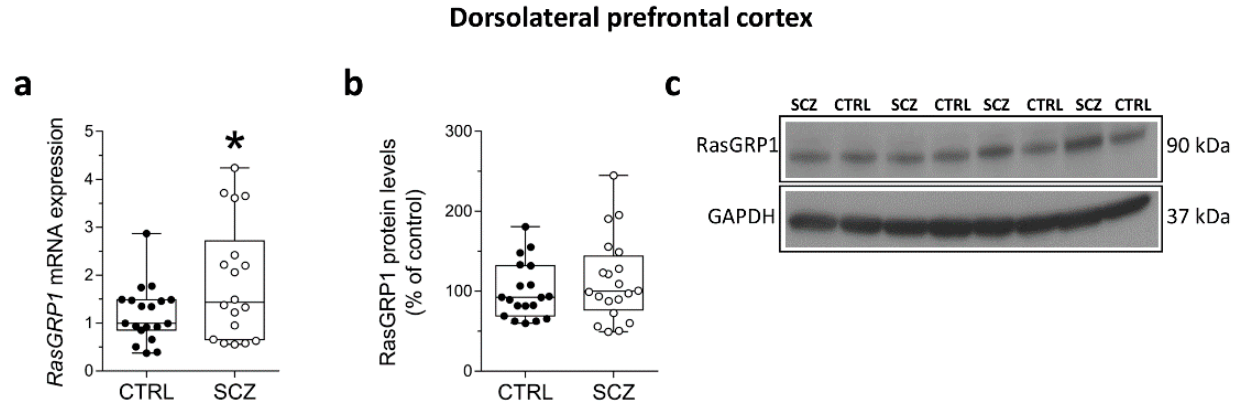
Figure 2. Increased RasGRP1 mRNA levels in the DLPFC of patients with SCZ . Expression levels of ( a ) RasGRP1 mRNA in the post-mortem DLPFC of SCZ patients (SCZ) ( n = 18) and control subjects (CTRL) ( n = 19). Quantification of western blot analysis of ( b ) RasGRP1 protein levels in the total homogenates of post-mortem DLPFC of SCZ-affected patients (SCZ) ( n = 20) and control subjects (CTRL) ( n = 19). The variations of RasGRP1 protein levels in patients affected by SCZ are expressed as percentage (%) of the control subjects. All markers were normalized to GAPDH for variation in loading and transfer; ( c ) representative images of immunoblots of RasGRP1 performed in the DLPFC of SCZ patients and control sub- jects. Each dot represents value from a single subject. * p < 0.05 compared to control group (Unpaired t -test). Multivariable regression analysis was performed against age and post-mortem interval